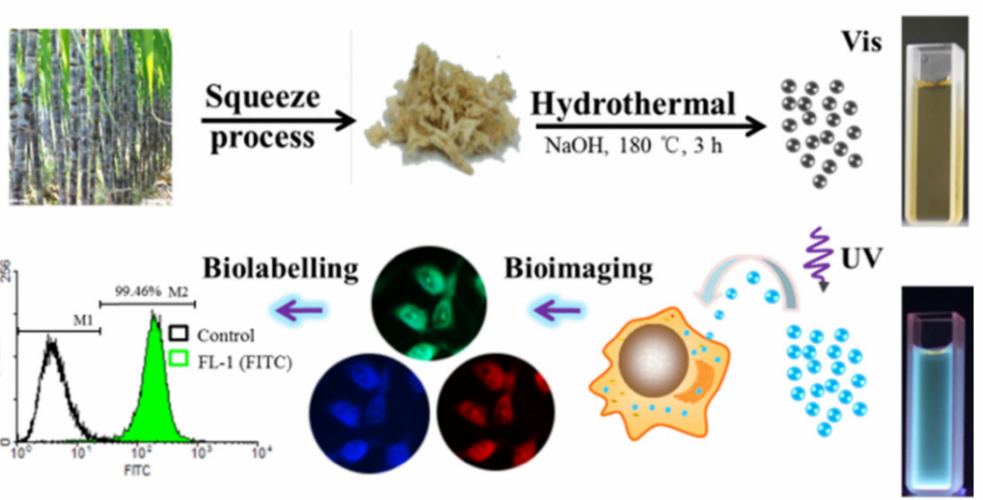
Figure 6. Schematic synthesis of bagasse-derived CDs from the HTC of the bagasse and the following biomedical applications